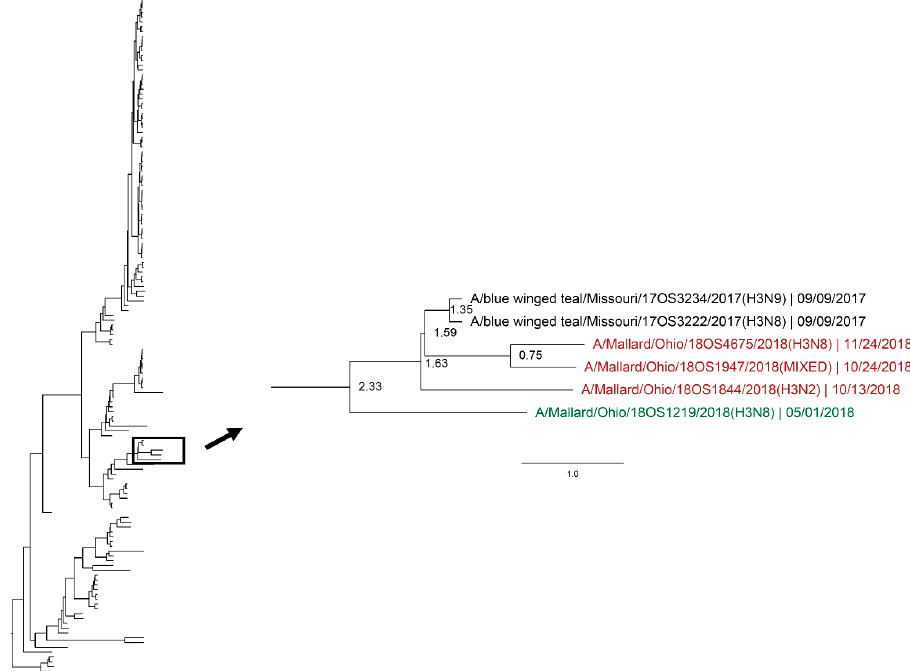
Figure 6. Maximum clade credibility tree of the H3 gene segment. Year-round, active influenza A virus surveillance was conducted in wild mallards ( Anas platyrhynchos ) in one location over two years. Time-stamped phylogenetic analysis with a general time reversible plus gamma substitution model revealed genetic persistence across multiple seasons, including the historically under-sampled spring season, in the HA gene segment. Highly supported clades (>0.95 posterior probability) containing viruses detected in the spring (green) who share a common ancestor with viruses detected in another season (red) throughout the study period with a time to most recent common ancestor of <2.5 years are highlighted. Node ages are indicated. Scale bar represents time in years.